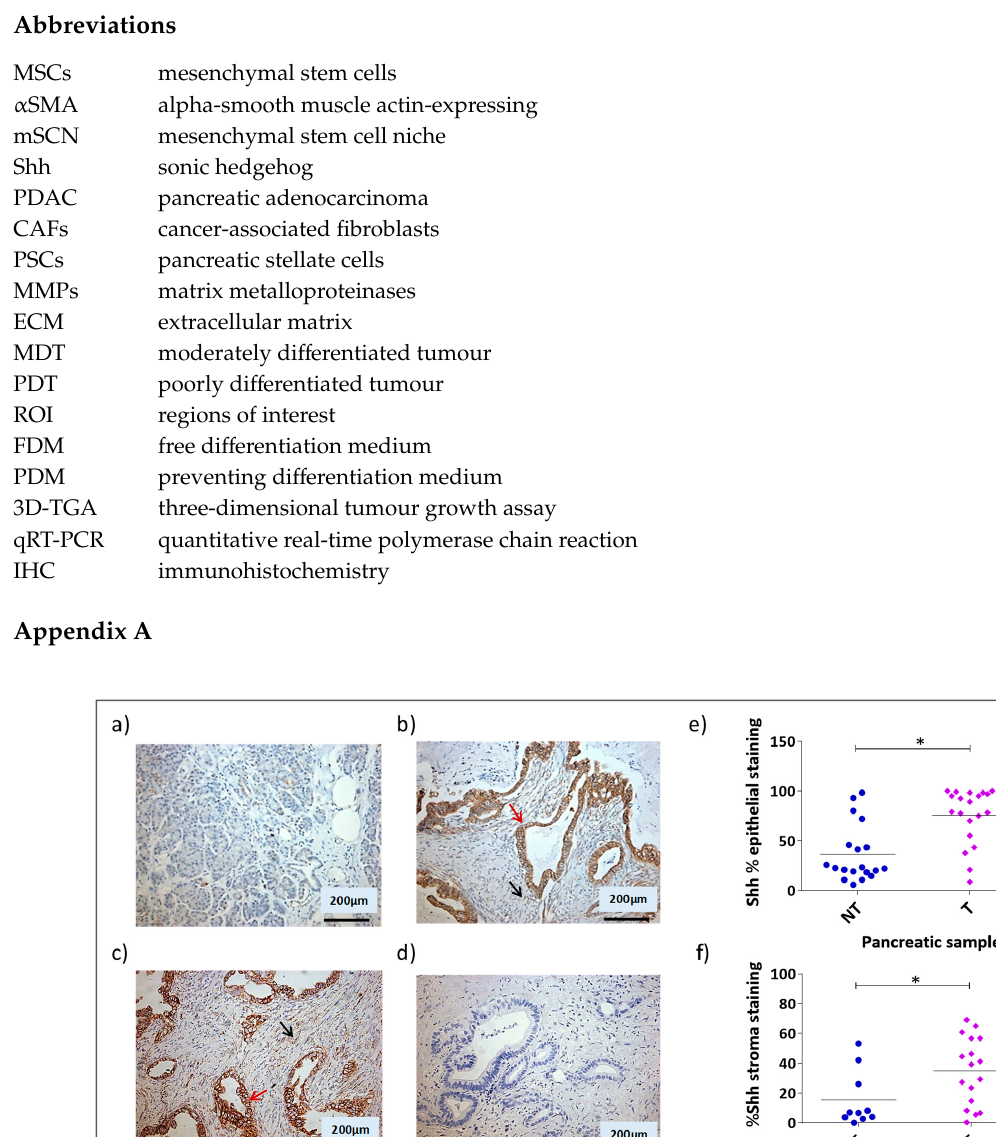
Figure A2. Vimentin expression in human pancreatic primary tissues. Example images of IHC analysis of vimentin protein expression in: ( a ) normal pancreatic human tissues, ( b ) moderately differentiated pancreatic tumour and ( c ) poorly differentiated pancreatic human tumour, ( d ) Negative control demonstrating absence of staining in PDT tissue when an isotype control antibody was substituted for the specific antibody to the target.